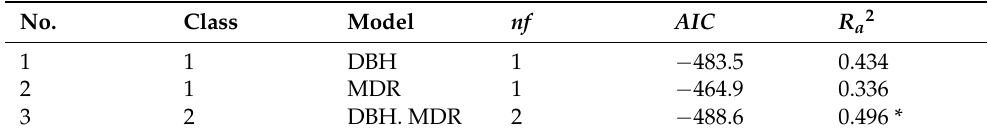
Table 11. Performances of candidate models for predicting wood density based on different models (control variant).